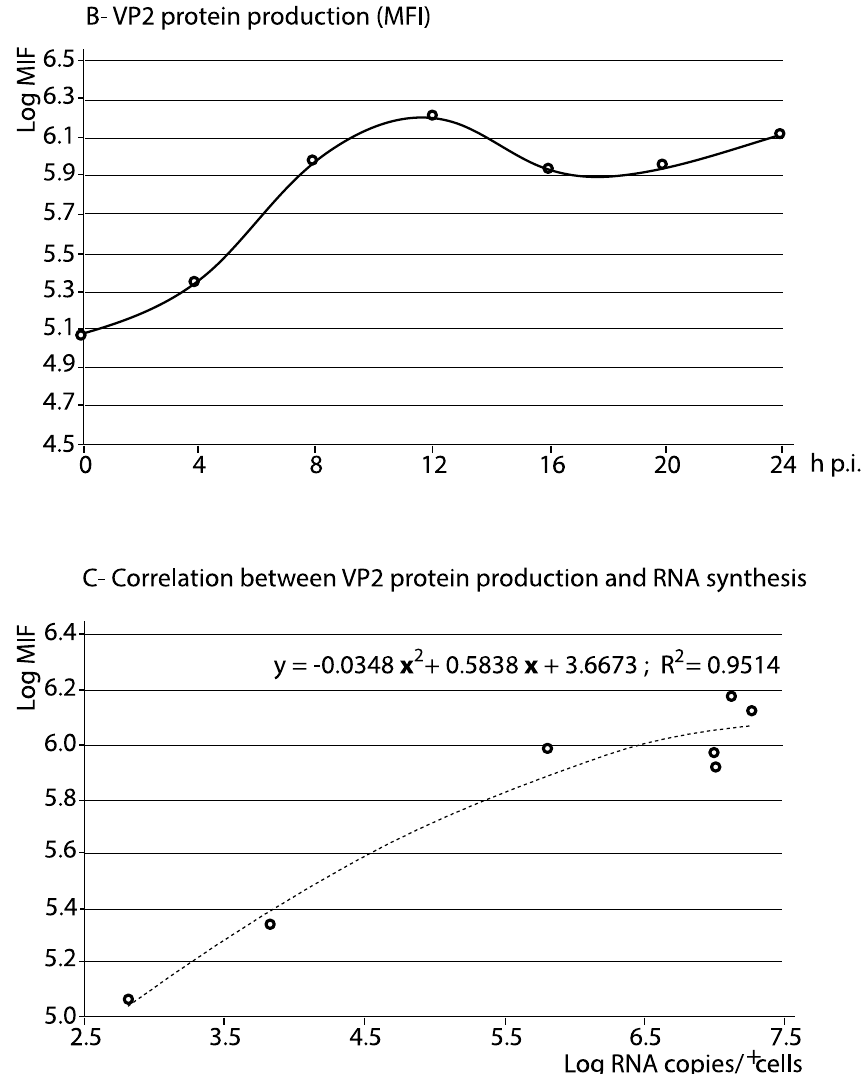
Figure 4. Quantification of VP2 protein production and RNA synthesis. The kinetics of RNA synthesis ( A ) and VP2 protein production ( B ) were studied in the first 24 h of viral replication in BF-2 cells. In addition, the correlation between both has been assessed ( C ). Each data corresponds to a single data point.